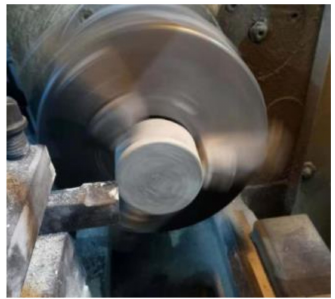
Figure 1. SHPB sample